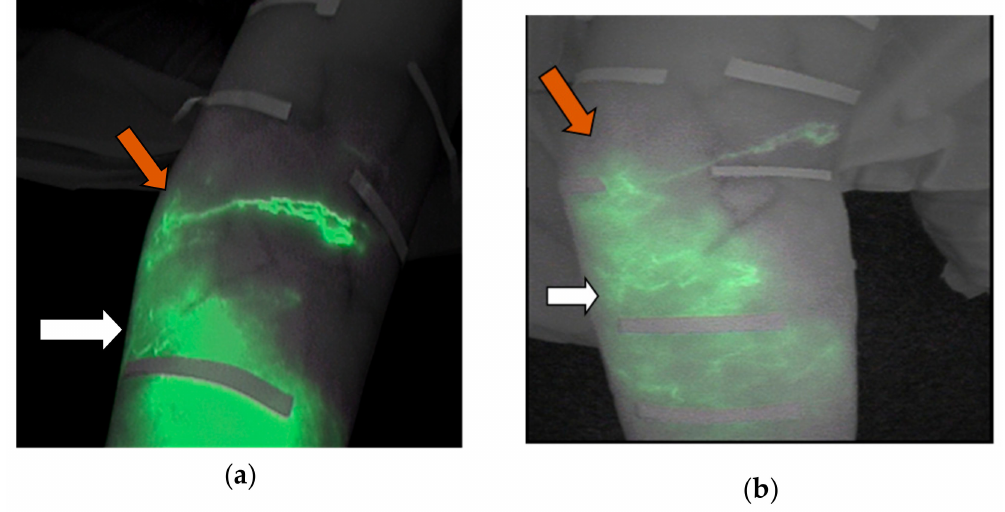
Figure 5. ( a ) Image captured before the treatment. The white arrow shown indicates the stardust pattern and the orange indicates a splash pattern. ( b ) Image captured after the treatment. The white arrow indicates a splash pattern and the orange arrow shows a linear pattern. The splash pattern evolved preferably towards normality in the most distal body regions (Figure